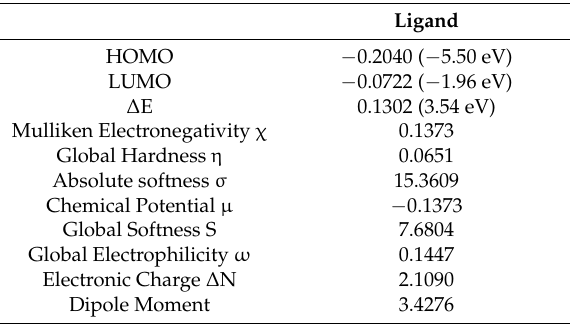
Table 1. Quantum chemical